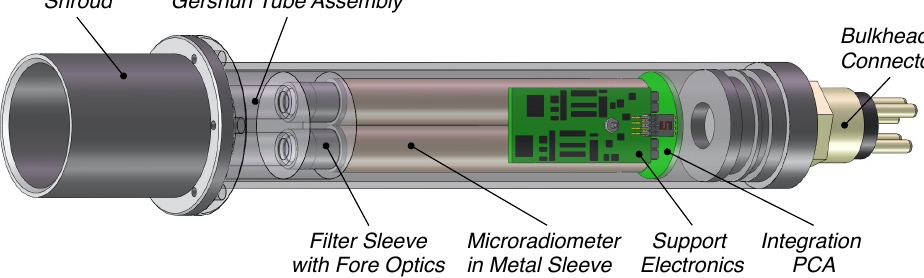
Figure 2. A two-channel radiance sensor optimized for autonomous above-water platforms (e.g., a UAV) with a 1.3in (3.4cm) diameter and 1.5in (3.8cm) long shroud attached to a 1.2in (3.0cm) diameter housing that is 7.5in (19.1cm) long. The total weight is 0.5lb